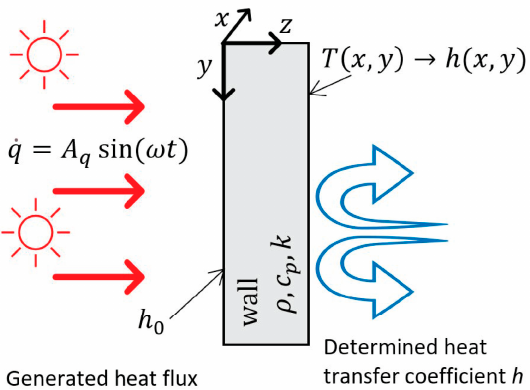
Figure 1. Simplified scheme of the method. On the left side is the illuminated side (side of the generated heat flux) and on the right side is the measured side—for more details on the methodology, see